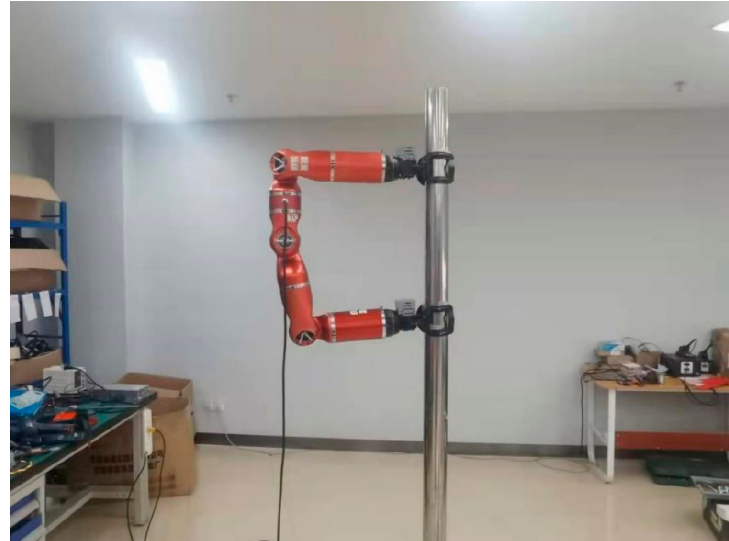
Figure 28. The robot climbing speed